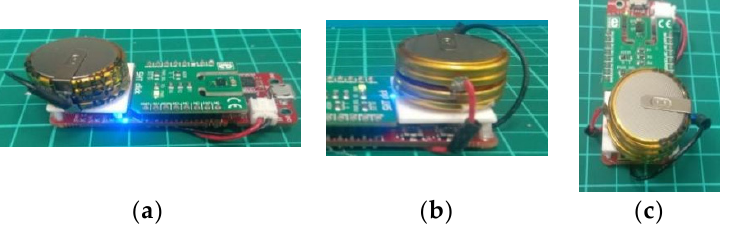
Figure 9. Wireless climate sensor node prototype: ( a ) side view; ( b ) energy source (supercapacitor); ( c ) top view.